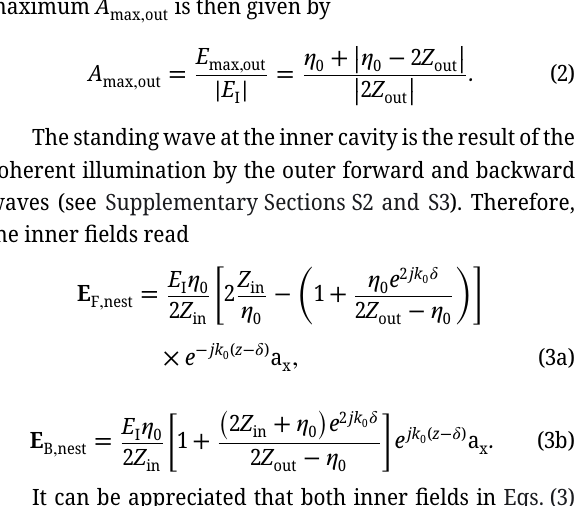
possible since dissipation in metal appearing at high fre- quencies would strongly degrade the performance of the cavity (see Supplementary Section